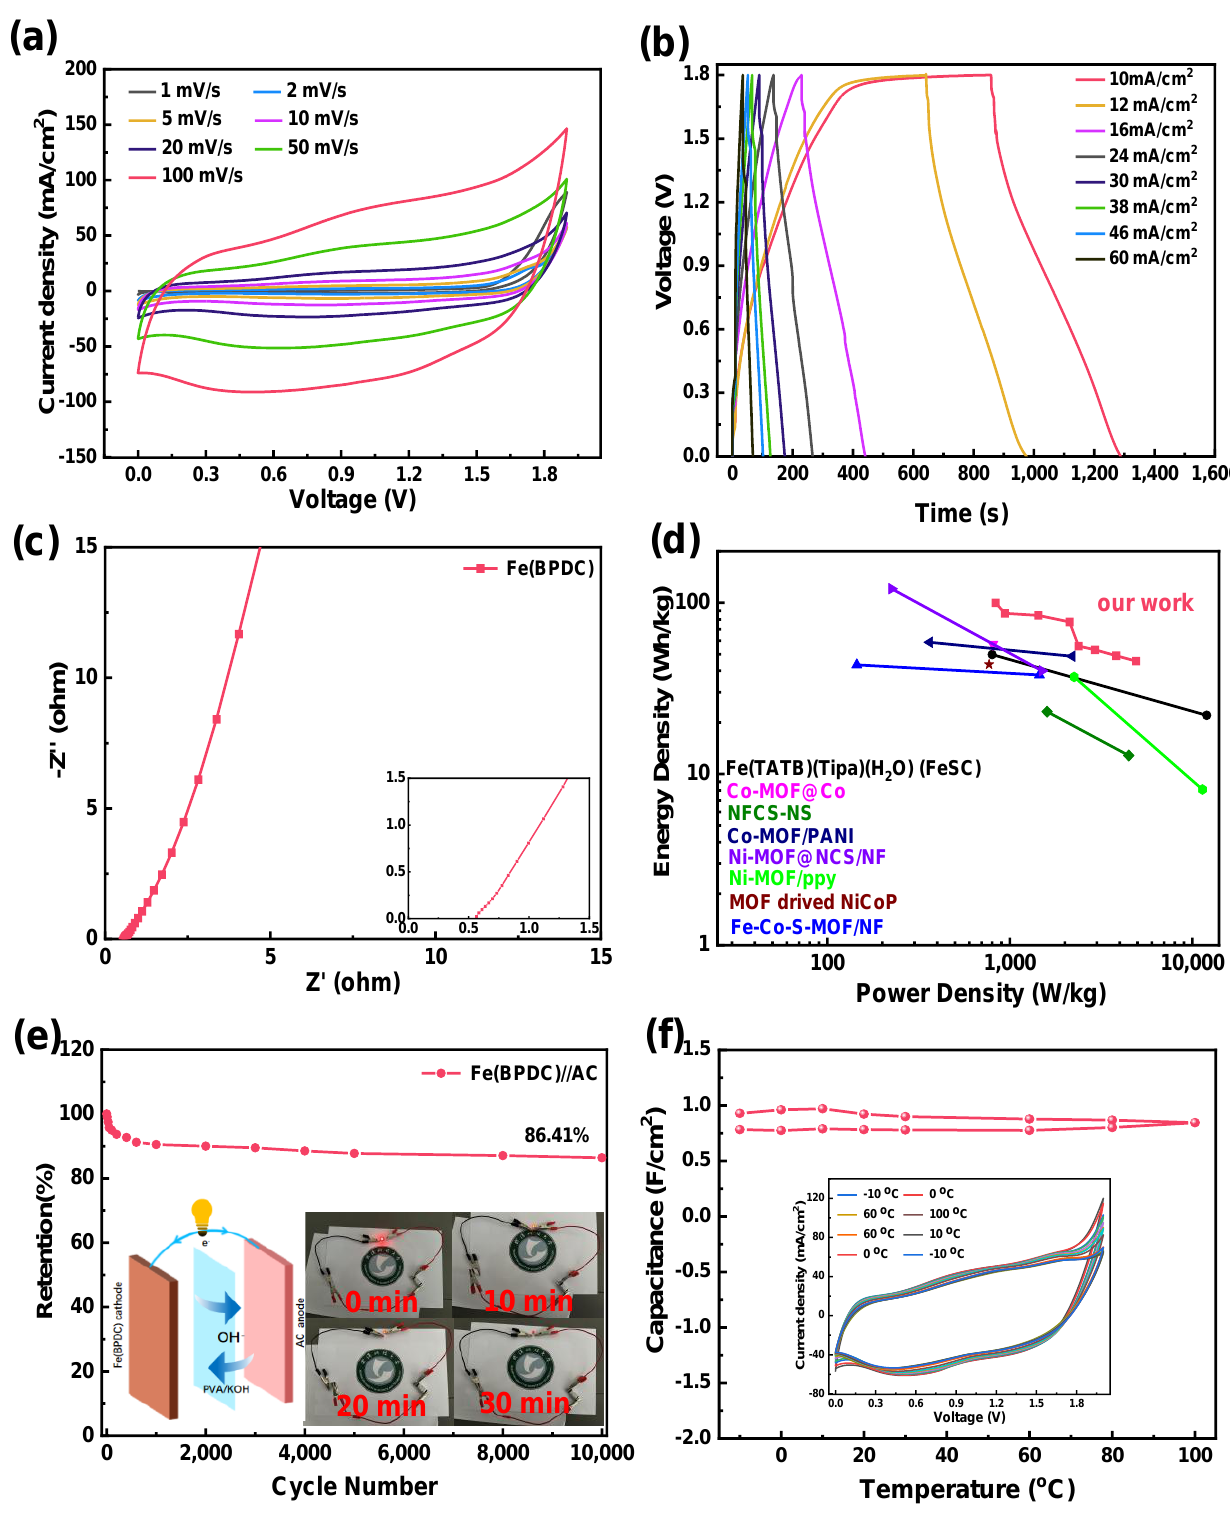
Figure 5. ( a ) CV curves of the Fe(BPDC)//AC at the scan rate of 1 to 100 mV/s. ( b ) GCD curves at different current densities of Fe(BPDC)//AC. ( c ) EIS spectra of Fe(BPDC)//AC. ( d ) Ragone plot comparison of our Fe(BPDC)//AC with some reports in the literature. ( e ) Cycling stability of Fe(BPDC)//AC. (Inset: image of a bulb (2 V) lit up for different periods of times, respectively. ( f ) Capacitance at different temperatures. (Inset: CV curves at different temperatures).